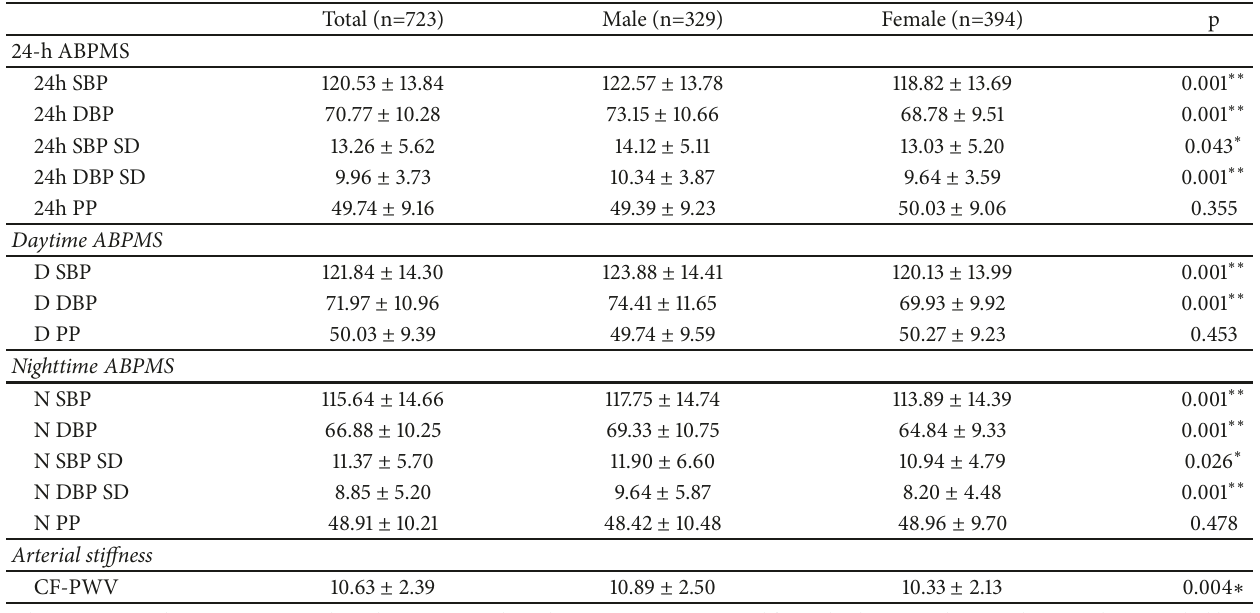
Table 2: 24h ambulatory blood pressure monitoring parameters and CF-PWV of subjects in general, male, and female